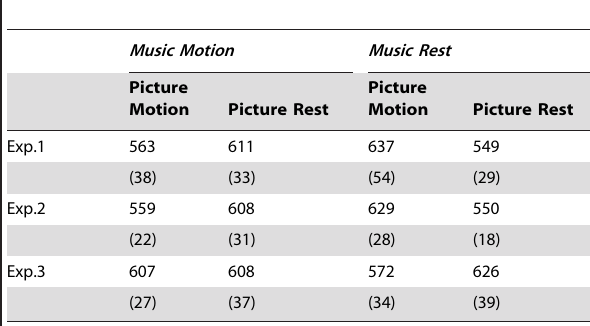
Table 1. Mean response time (in milliseconds) per condition for the three